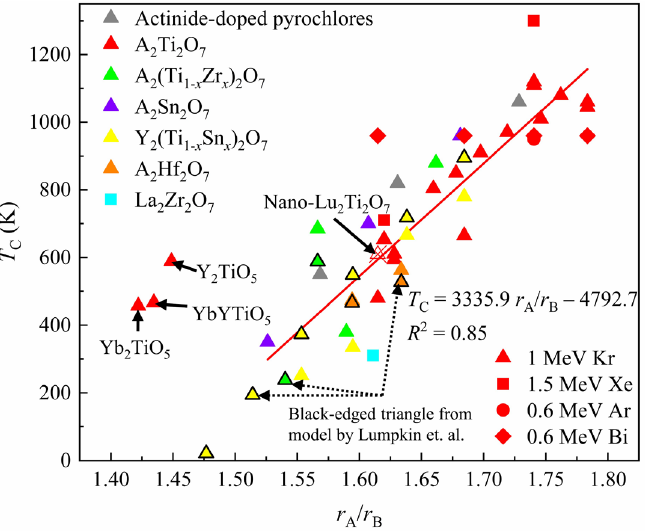
Figure 13. The critical amorphization temperature T C of pyrochlores irradiated by ions as a function of the cation ionic radius ratio r A / r B . The triangle, square, circle, and rhombus represent irradiated ions 1 MeV Kr, 1.5 MeV Xe, 0.6 MeV Ar, and 0.6 MeV Bi, respectively. Grey, red, green, purple, yellow, orange, and blue represent actinide doped pyrochlores [66], titanate pyrochlores (A 2 Ti 2 O 7 ) [68,93,133,190–192,195], Zr-doped titanate pyrochlores (A 2 (Ti 1 − x Zr x ) 2 O 7 ) [55,139], stannate pyrochlores (A 2 Sn 2 O 7 ) [55,194], Sn-doped yttrium titanate pyrochlores (Y 2 (Ti 1 − x Sn x ) 2 O 7 ) [55], hafnate pyrochlores (A 2 Hf 2 O 7 ) [55], and lanthanide zirconate pyrochlores (La 2 Zr 2 O 7 ) [91], respectively. Additionally, the triangles with black edges represent data [55] calculated from the model proposed by Lumpkin et al. (Equation (2) in Ref. [196]). The red solid line is obtained by linear fitting all data points irradiated by 1 MeV Kr ion, except the three points with black arrows (Y 2 TiO 5 , Yb2TiO 5 and YbYTiO 5 ) and the data marked by black-edged triangles.